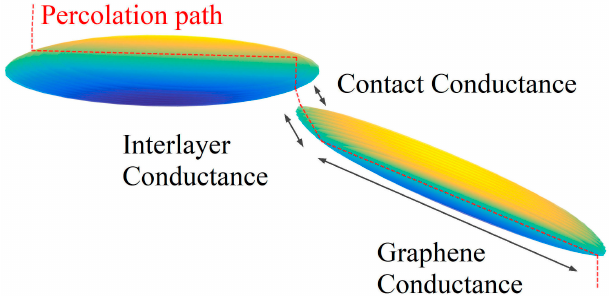
Figure 2. A diagram of G graphene (the conductance of graphene), G interlayer (the conductance between the top and bottom layer of a GNP), and G contact (the tunneling conductance between a pair of GNPs).